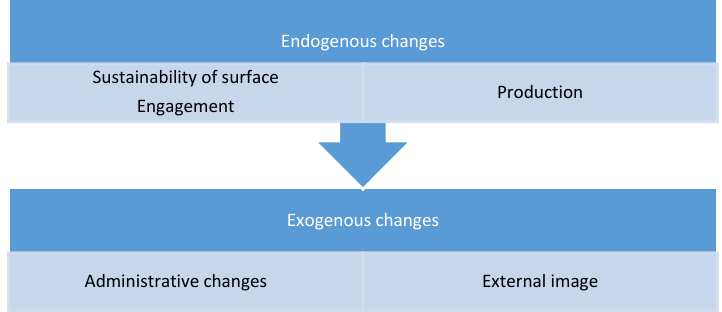
Figure 3. Framework of changes to improve the economic potential of CFs.